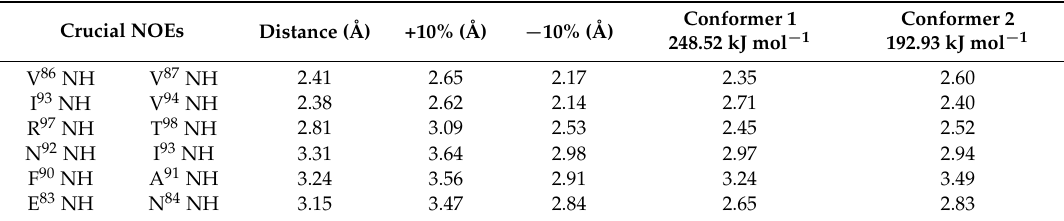
Table 3. NOE distance constraints and corresponding distances for each class of conformers for the linear MBP 82–98 (A 91